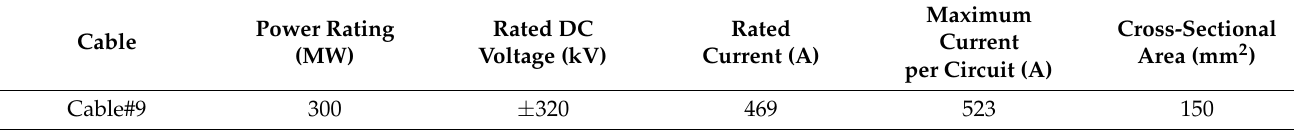
Table A6. DC-cables